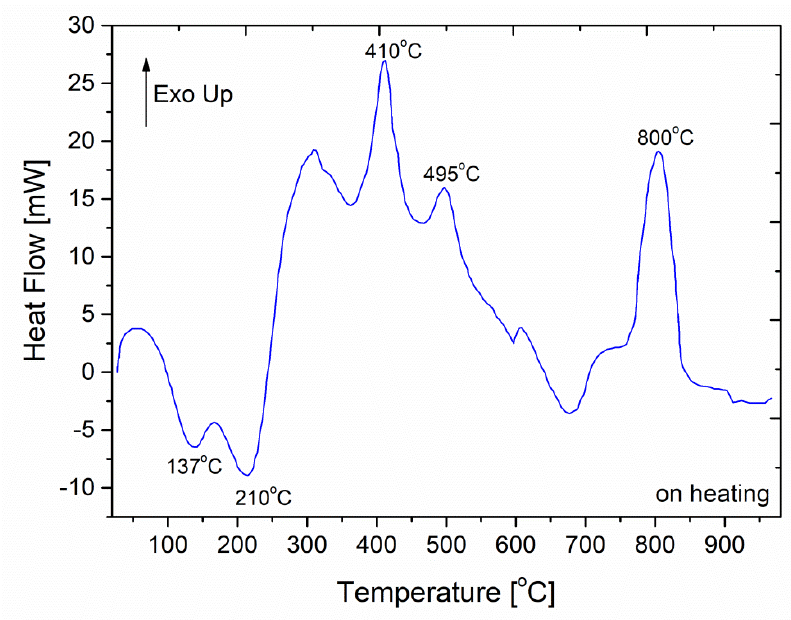
Figure 8. Representative differential thermal analysis (DTA) curve for a glassy electrolyte sample recorded in an ambient air atmosphere.